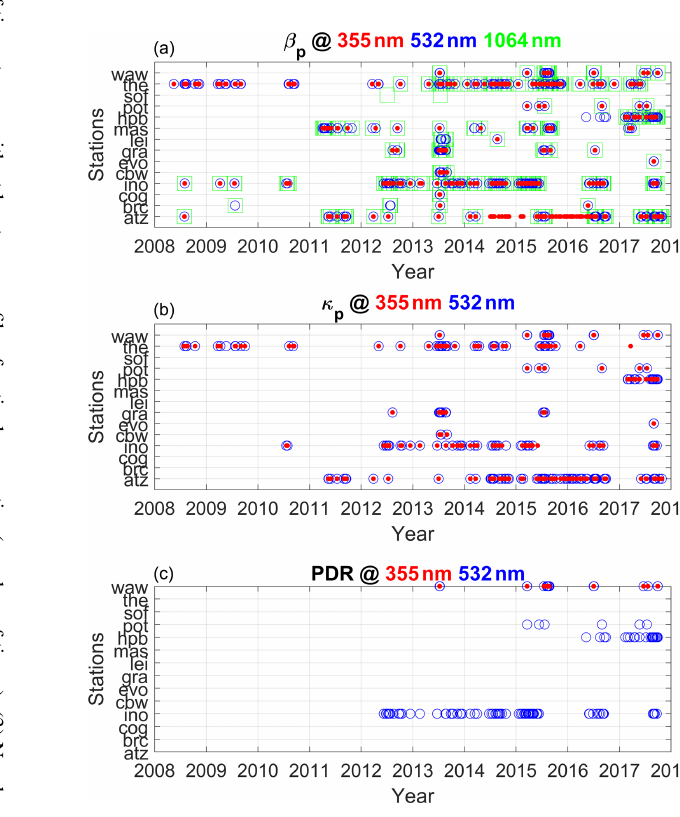
Figure 3. Number of “b”- and “e”-files available from 14 EAR- LINET stations providing data for Forest Fire over the 2008–2017 period.